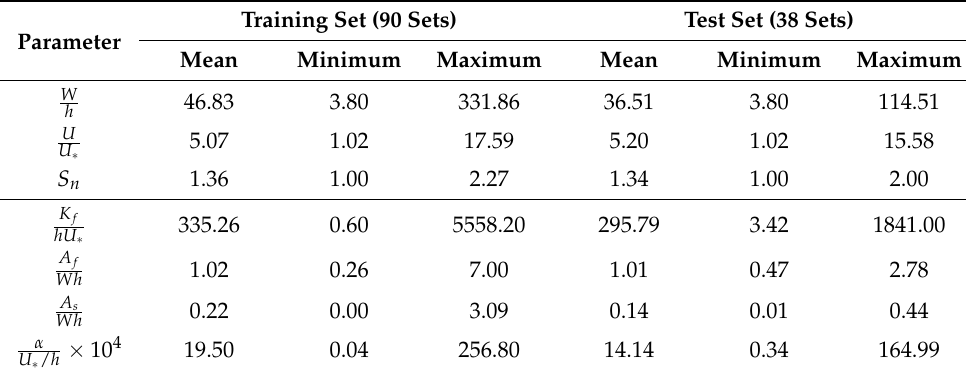
Table 1. Statistics of the transient storage